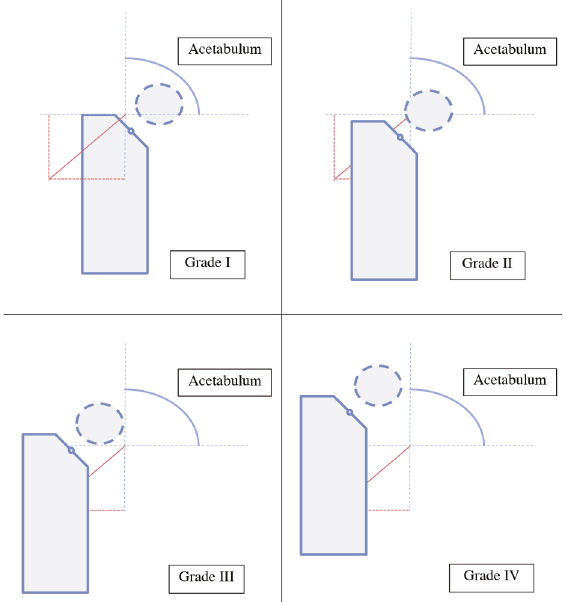
Schematic grading of DDH Severity based on IHDI Fig. 2: